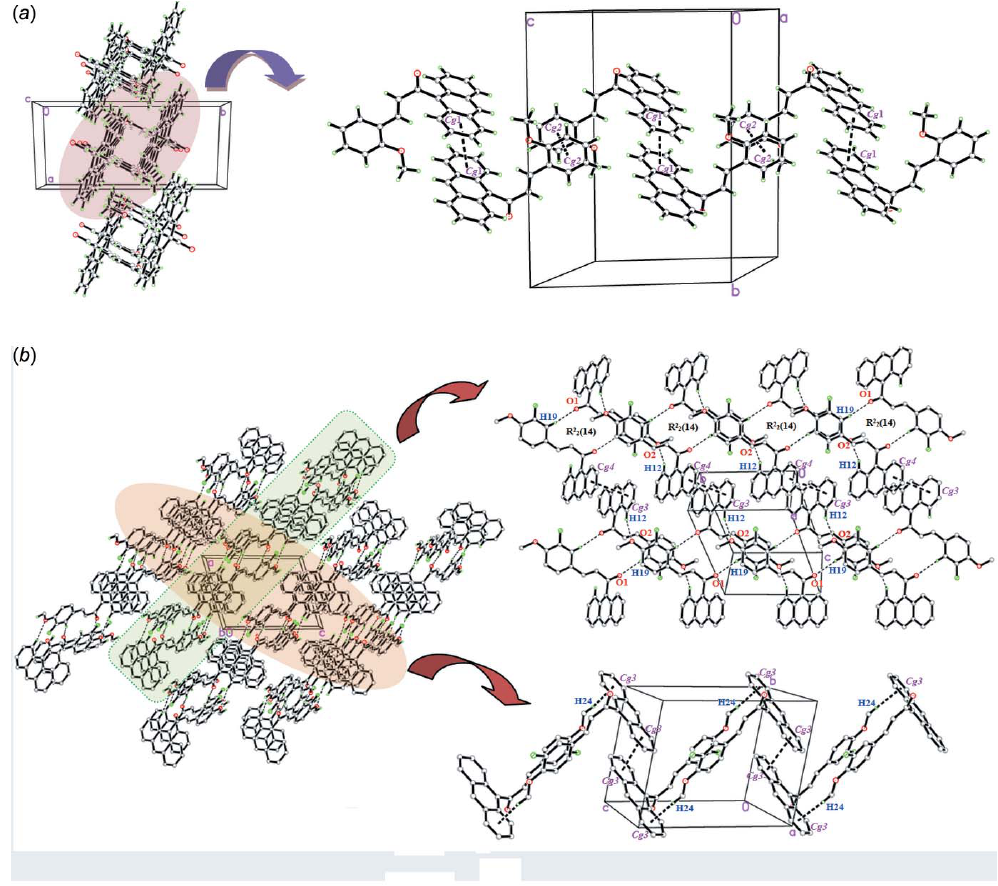
Figure 2 ( a ) Crystal packing for compound (I) viewed along the a axis showing weak (cid:2) – (cid:2) interactions (dashed lines), where Cg 1 and Cg 2 are the centroids of the C1–C6 and C18–C22 rings, respectively, and ( b ) Weak C—H (cid:2)(cid:2)(cid:2) O, C—H (cid:2)(cid:2)(cid:2) (cid:2) and (cid:2) – (cid:2) interactions (dashed lines) for compound (II),, forming R 2 graph-set motifs, where Cg 3 and Cg 4 are the centroids of the C8–C13 and C1–C6 rings, respectively.